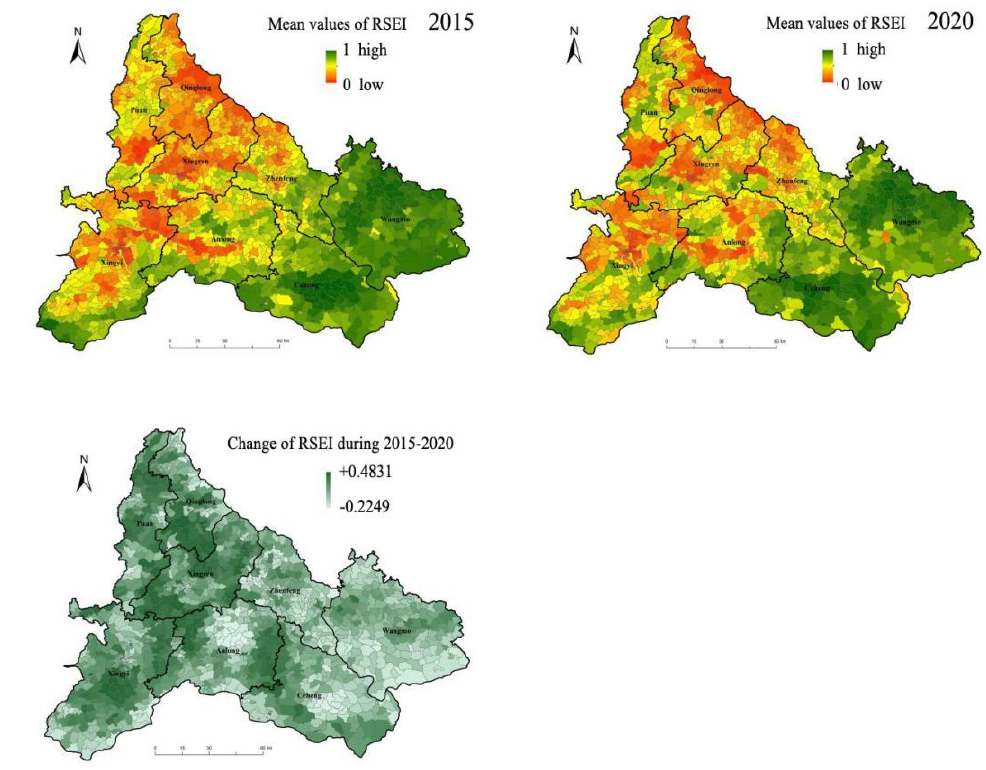
Figure 7. Change map of RSEI during 2015–2020.